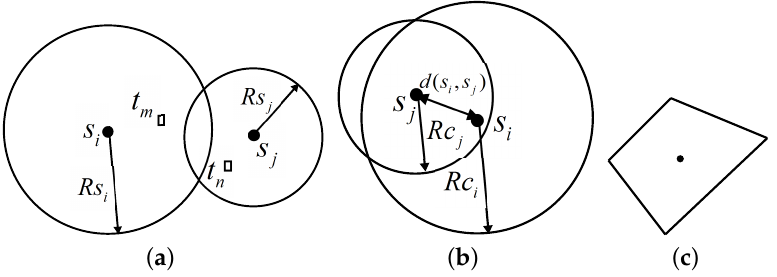
Figure 4. Sensing and communication models. a ) Sensing model; ( b ) communication model; ( c ) convex sensing and communication